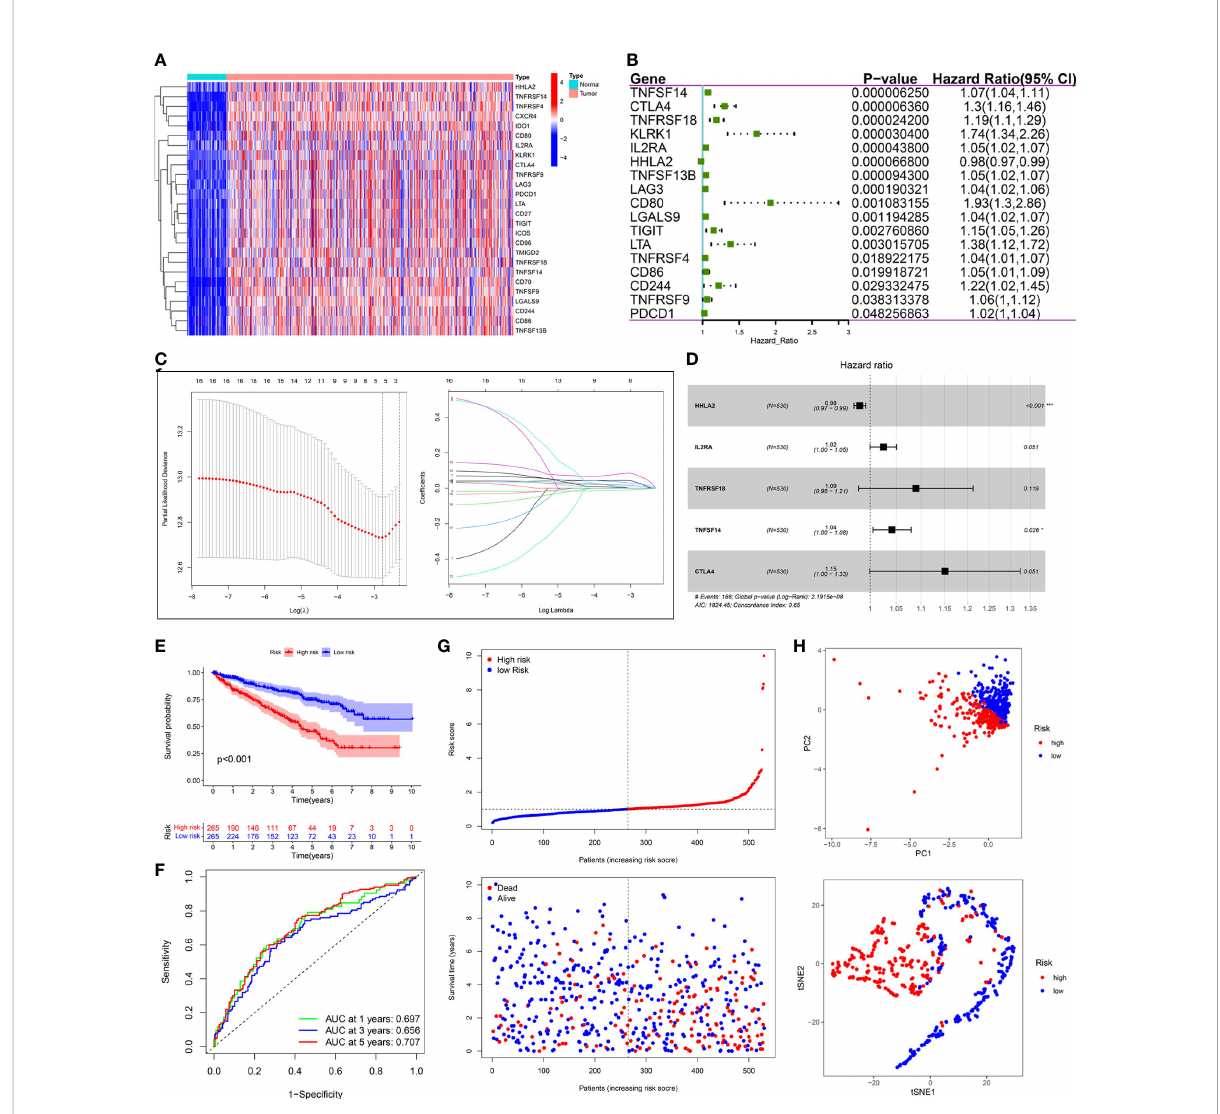
FIGURE 8 Construction of prognostic PRIs signature based on the TCGA KIRC cohort. (A) The heatmaps of 26 differentially expressed PRIs in KIRC tissues and normal tissues. (B) Forest plot of univariate Cox regression analysis of PRIs related to the OS. (C) LASSO coef fi cients pro fi les of the 5 PRIs in KIRC. (D) Forest plot of multivariate Cox regression analysis of 5 PRIs in KIRC. (E) Kaplan-Meier analysis of KIRC patients strati fi ed by the median risk score in the TCGA cohort. (F) The time-dependent ROC curve for OS in the TCGA cohort. (G) The distribution of the risk score and OS status in the TCGA cohort. (H) PCA and t-SNE analyses in the TCGA